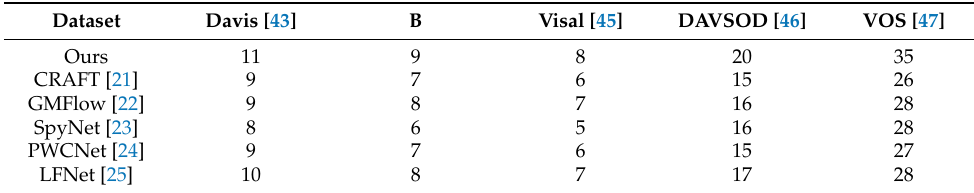
Table 3. The total time taken by different optical flow models to generate optical flow for different datasets, with the time unit in minutes, “Ours” represents the optical flow model proposed in this paper.